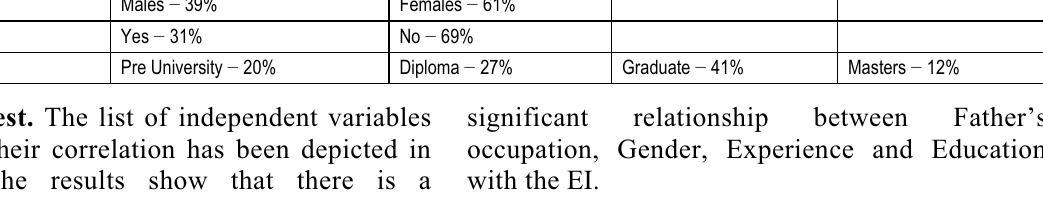
Table 4. Correlation